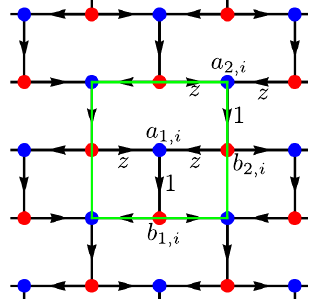
Figure 35: The set-up of the brick lattice used to map between the 2D classical model H and the 1D quantum model H 1D [ Eq. 51 ] . To simplify the mapping a non-minimal, 4-site (6-bond) unit cell is chosen and the bond directions are different from in the main text. The four Grassmann variables contained within a unit cell are labelled a